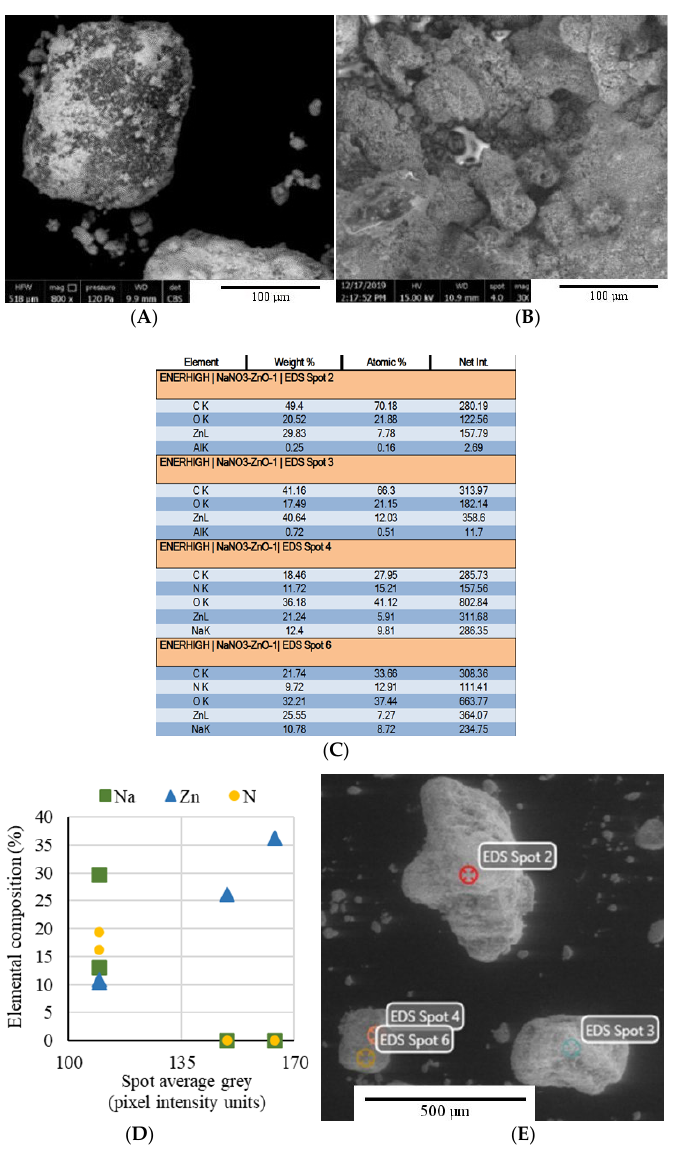
Figure 2. SEM micrograph of NaNO 3 –ZnO microcapsule before ( A ) and after repeated melting– solidification cycles ( B ). EDS analysis ( C ) of 4 spots in a same picture ( E ), confirming ( D ) that light grey spots contain Zn and do not contain Na or N.